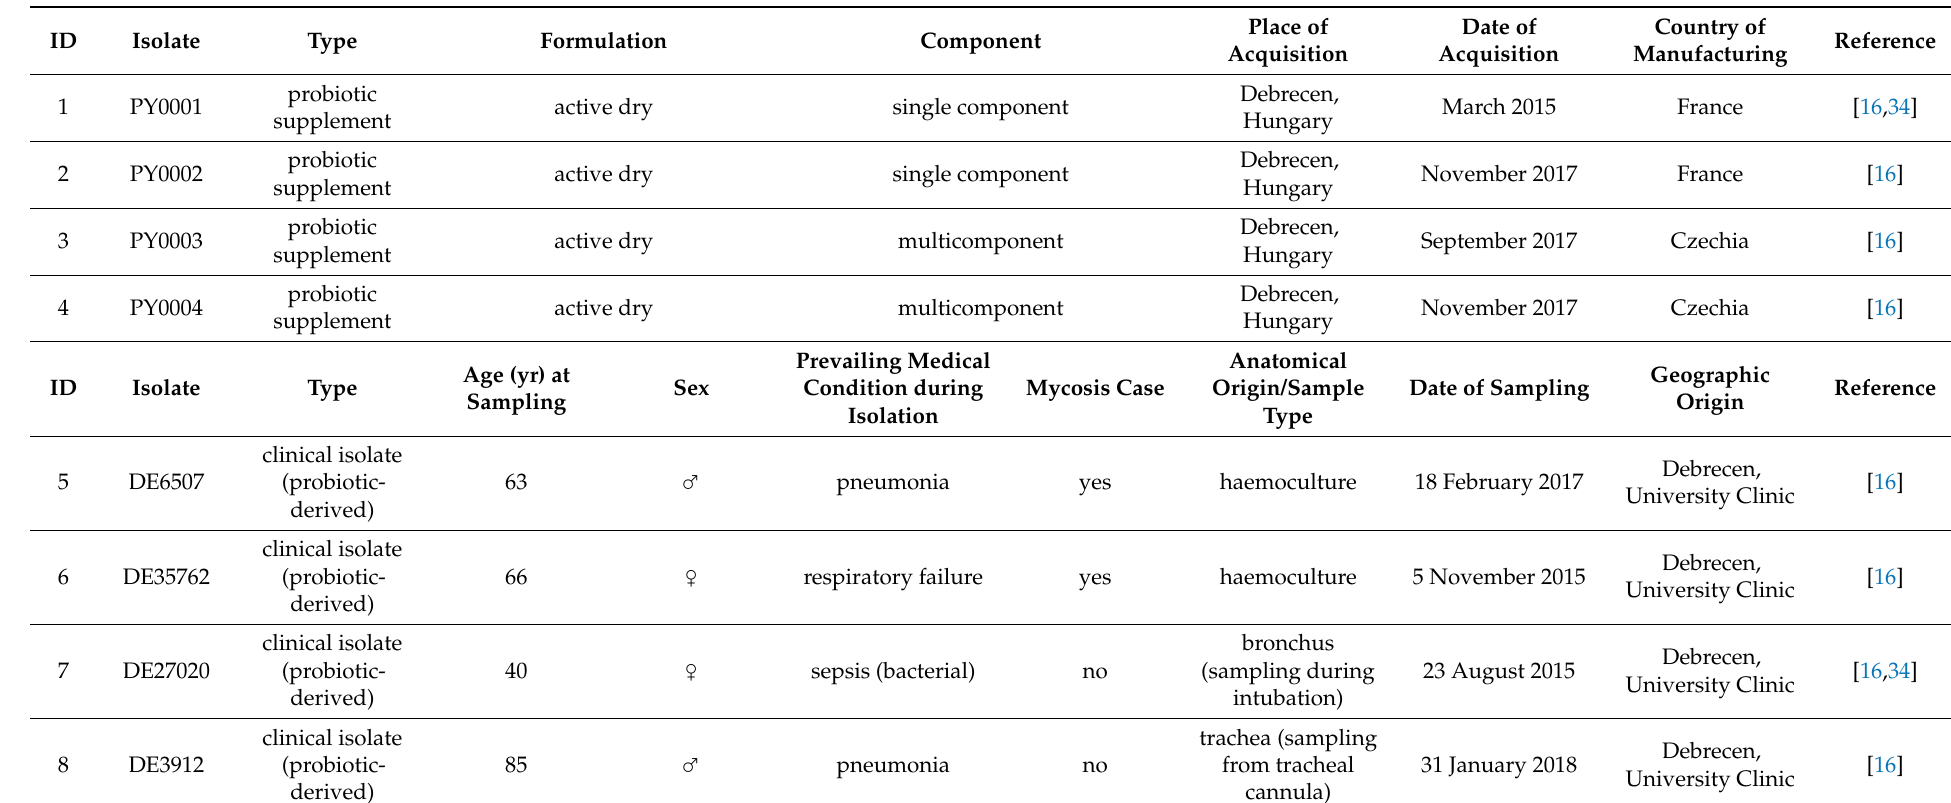
Table 1. Collection and patient data for the isolates used in this